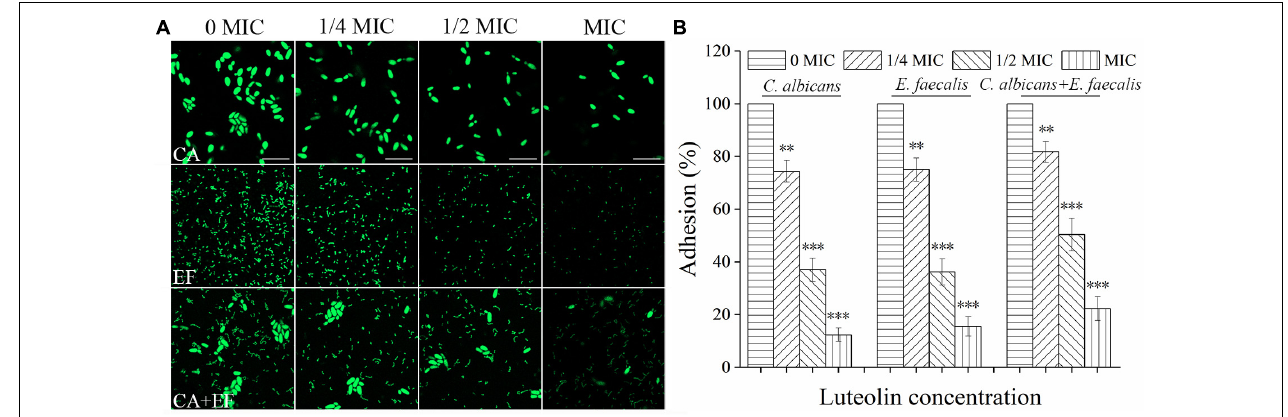
FIGURE 3 | Luteolin exposure reduced cell adhesion of C. albicans SC5314 (CA) and E. faecalis 20033 (EF) single and dual species (CA + EF) on the glass surface. Cell adhesion was evaluated at final concentrations of luteolin ranging from 0 to 1 minimum inhibitory concentration (MIC) by confocal laser scanning microscope (CLSM) (A) (scale bars of 10 µ m) and viable cell counts (B) . Error bars are expressed as means ± standard deviation (SD). ∗ p < 0.05; ∗∗ p < 0.01; ∗∗∗ p < 0.001.